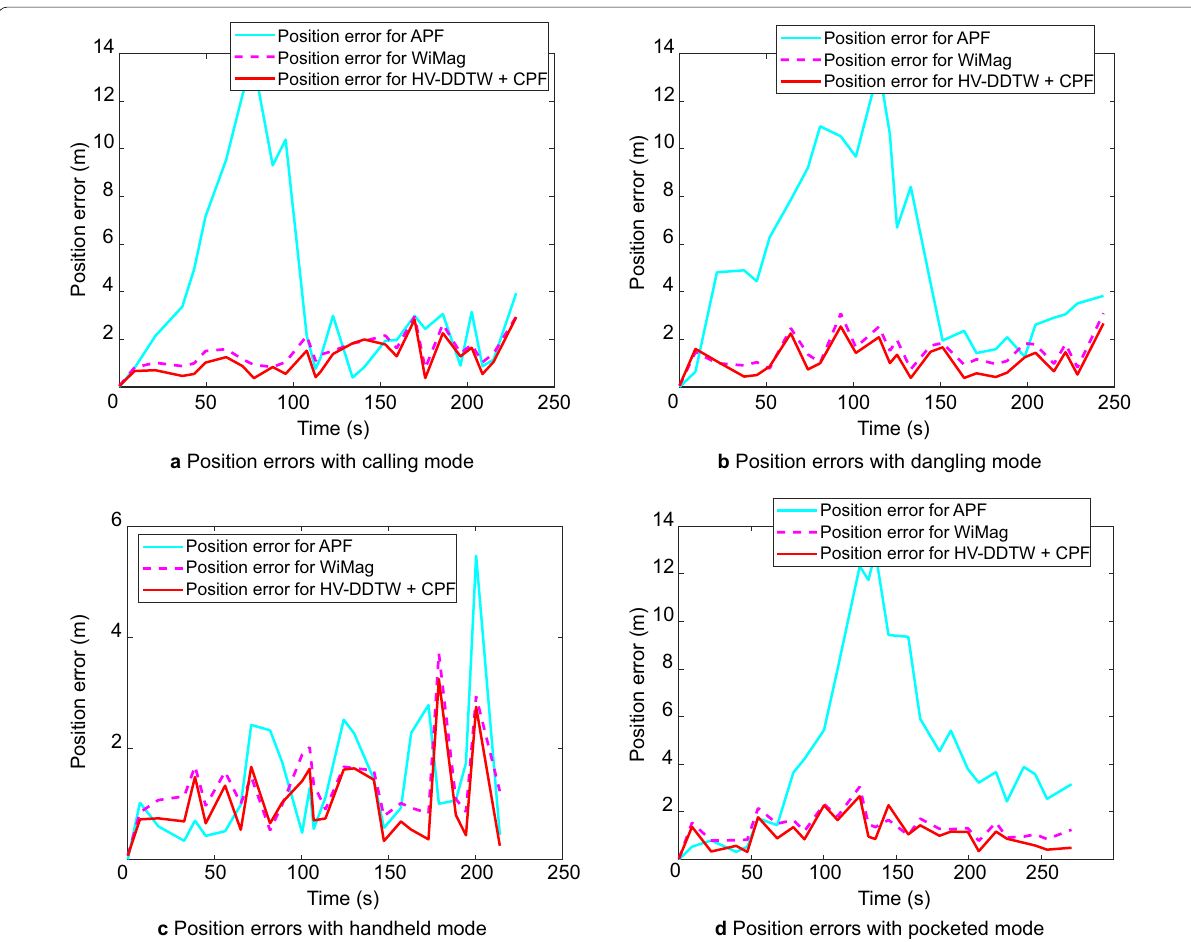
Fig. 20 Position errors with different